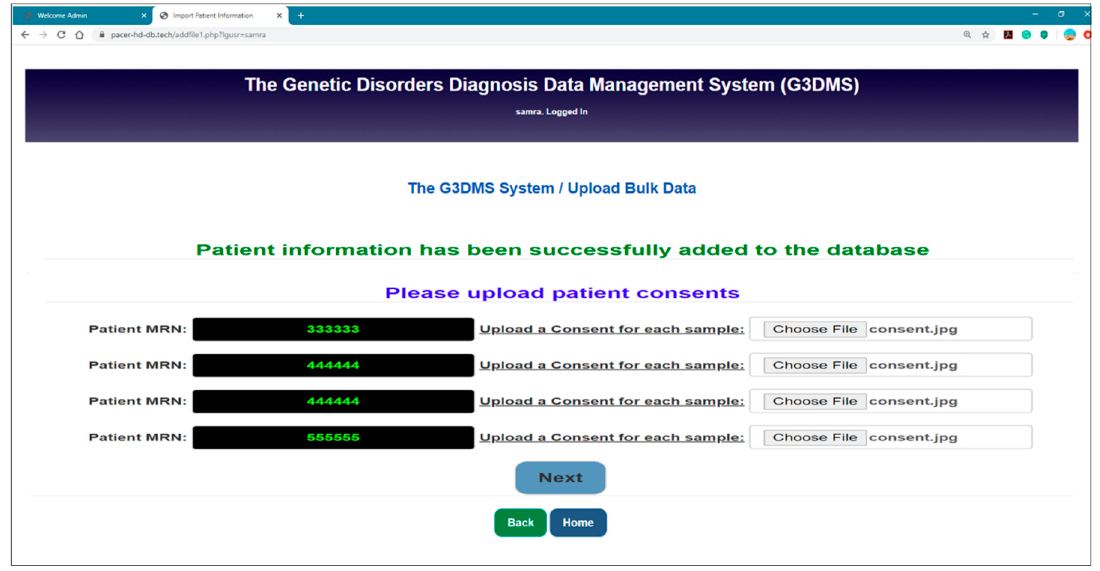
Figure 16. Upload bulk data: patients’ consents for YES value fields.